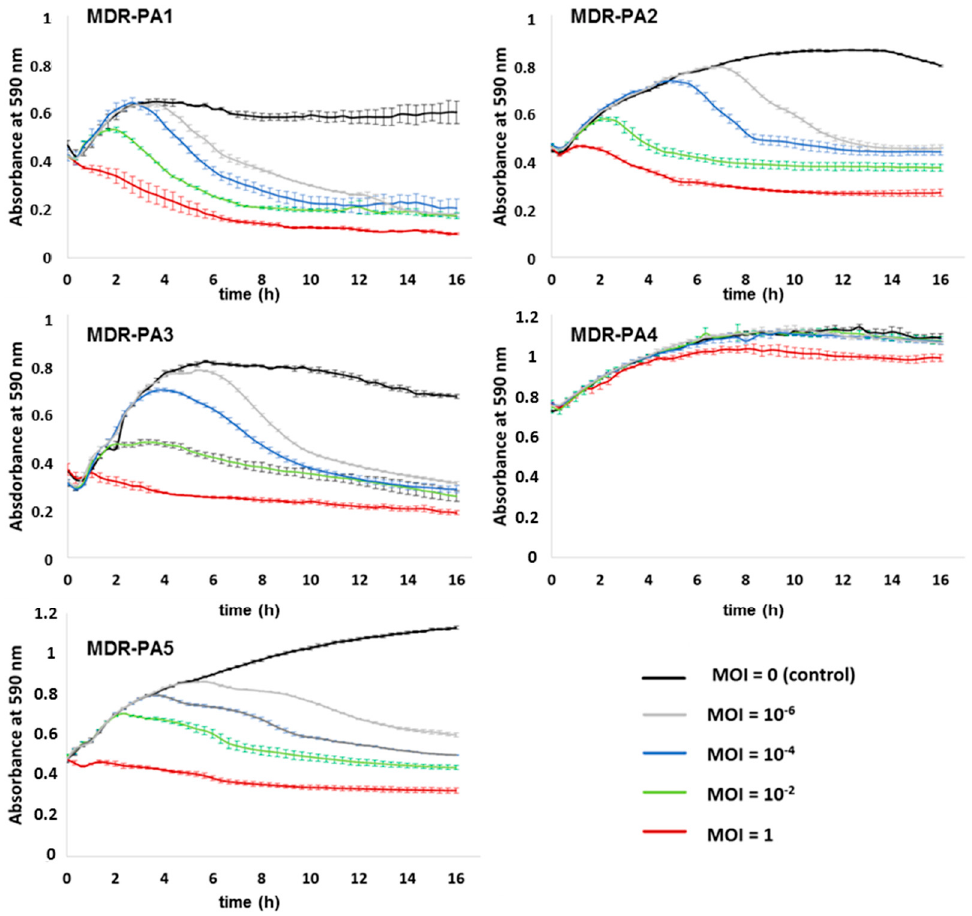
Figure 6. Activity of phage SL2 against planktonic cells of five different multi-drug resistant P. aeruginosa strains (MDR-PA1-5). Each experiment was performed in triplicate, and bars indicate standard deviation.